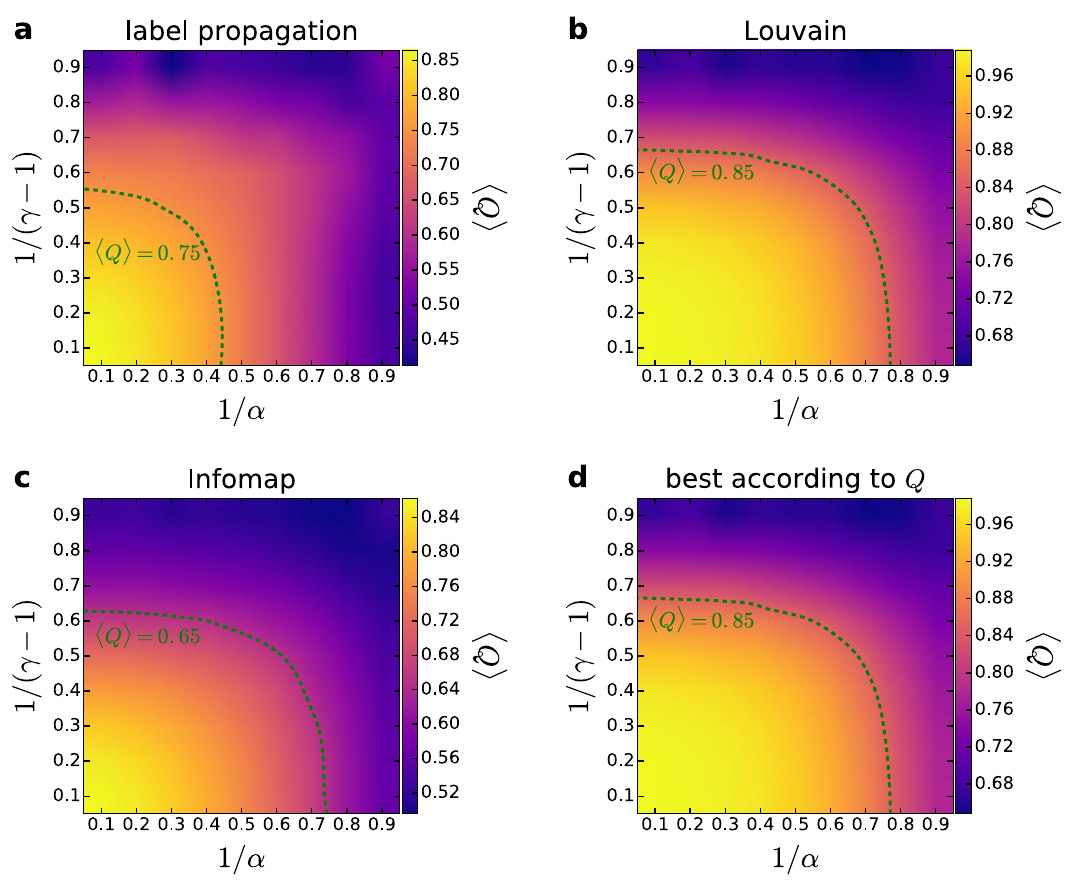
Figure 4. Modularity in the S 1 / H 2 model. We show the weighted modularity Q (indicated by the color, averaged over 100 samples) as a function of the model parameters 1 /α and 1 /(γ N 10,000 and expected average degree = asynchronous label propagation ( a ), Louvain ( b ), Infomap ( c ), and when the best community partition is taken from the three methods according to Q ( d